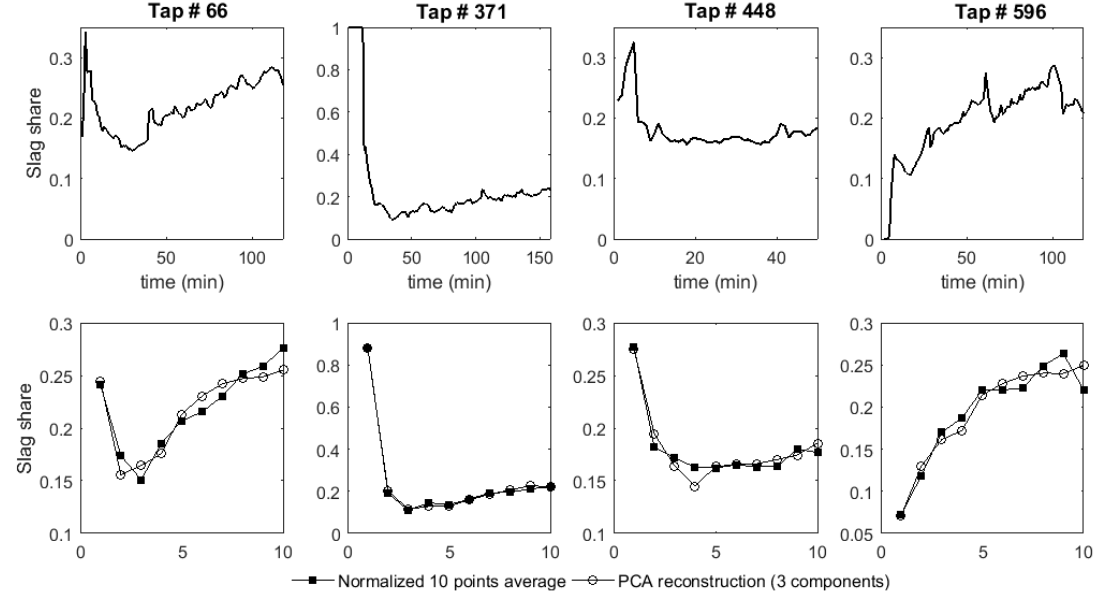
Figure 3. Slag share for the taps presented in Figure 2. Upper panels: one-minute values obtained from the measurements. Lower panels: information discretized into 10 points (solid squares) and principal component analysis (PCA) reconstruction (open circles).